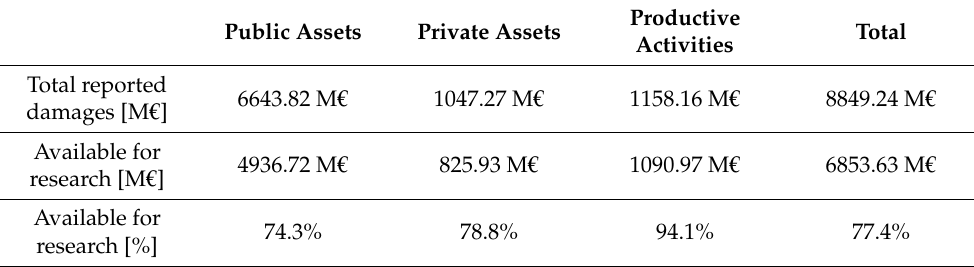
Table 1. Flood damage reported in Italy from September 2013 to November 2020, according to the National Civil Protection website, and available for the present